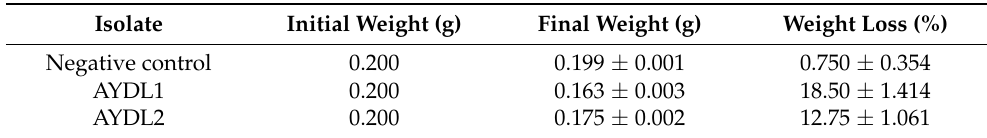
Table 1. Weight loss percentage of polystyrene (PS) microplastics in uninoculated negative control and the cultures of isolate AYDL1 and